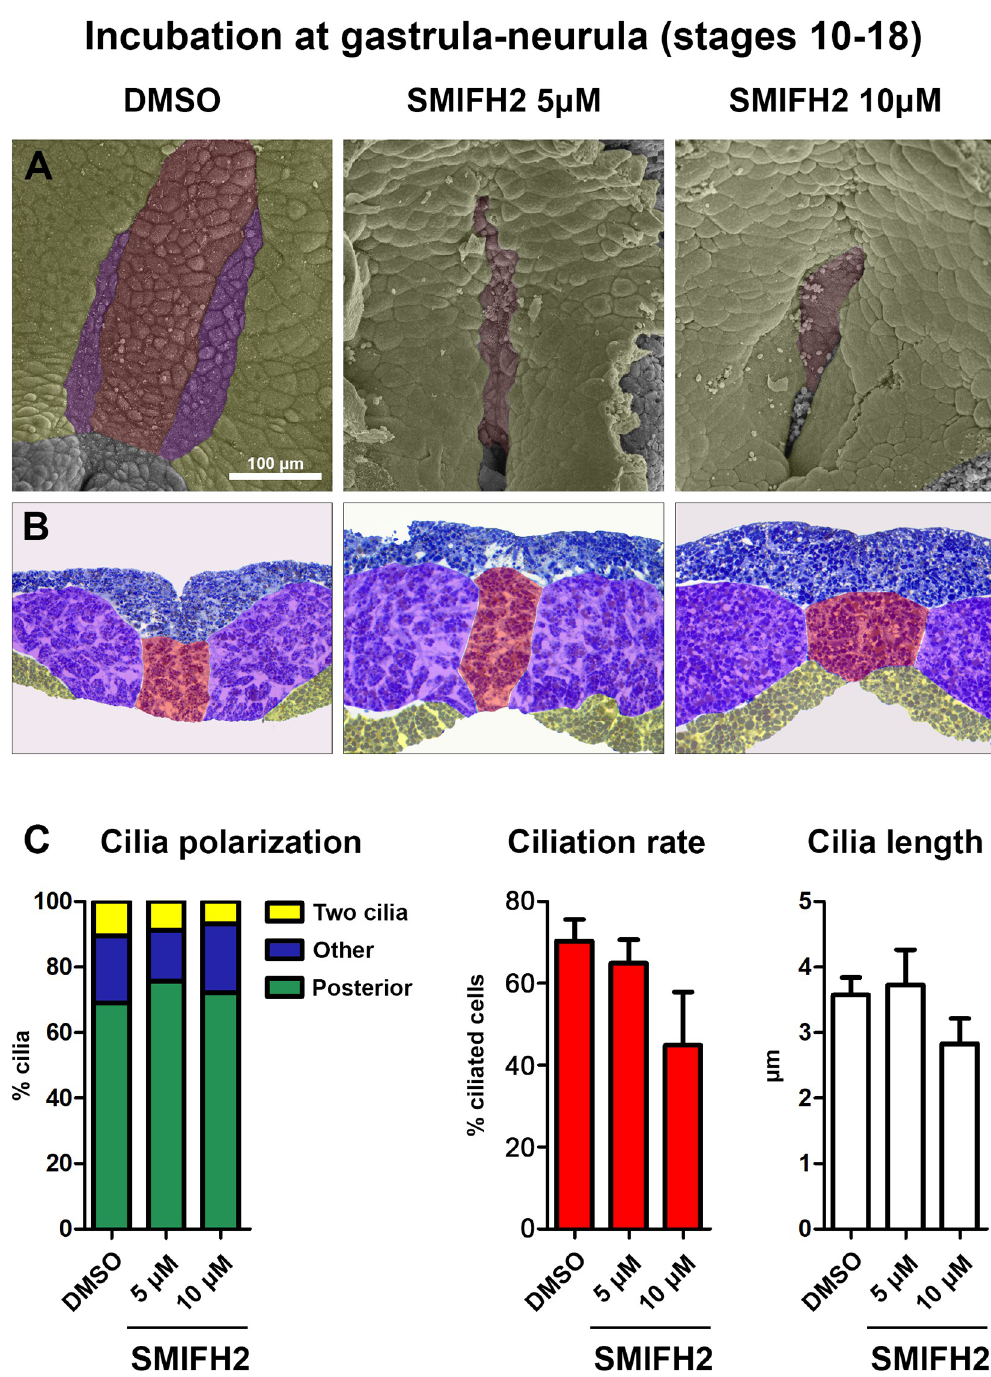
Fig 4. Formin inhibition at gastrula and neurula stages results in morphology defects of left-right organizer at stage 18. (A) Representative scanning electron microscopy images of GRP after exposure to various concentrations of formin inhibitor. (B) Representative histological sections through the GRP after exposure to various concentrations of formin inhibitor. Blue color indicates ectoderm, red–notochord and hypochord, violet–somitic mesoderm, yellow–endoderm. (C) Cilia polarization, cilia length and percentage of ciliated cells (ciliation rate) in embryos treated with DMSO and SMIFH2 (5 μ M and 10 μ M). Measurements were performed in notochordal GRP of 11, 14 and 9 embryos respectively (number of analysed cells = 303, 453 and 234 respectively). The apparent decrease of number of ciliated cells is non-significant (p- value = 0,295 for 10 μ M, t-test with Bonferroni correction).